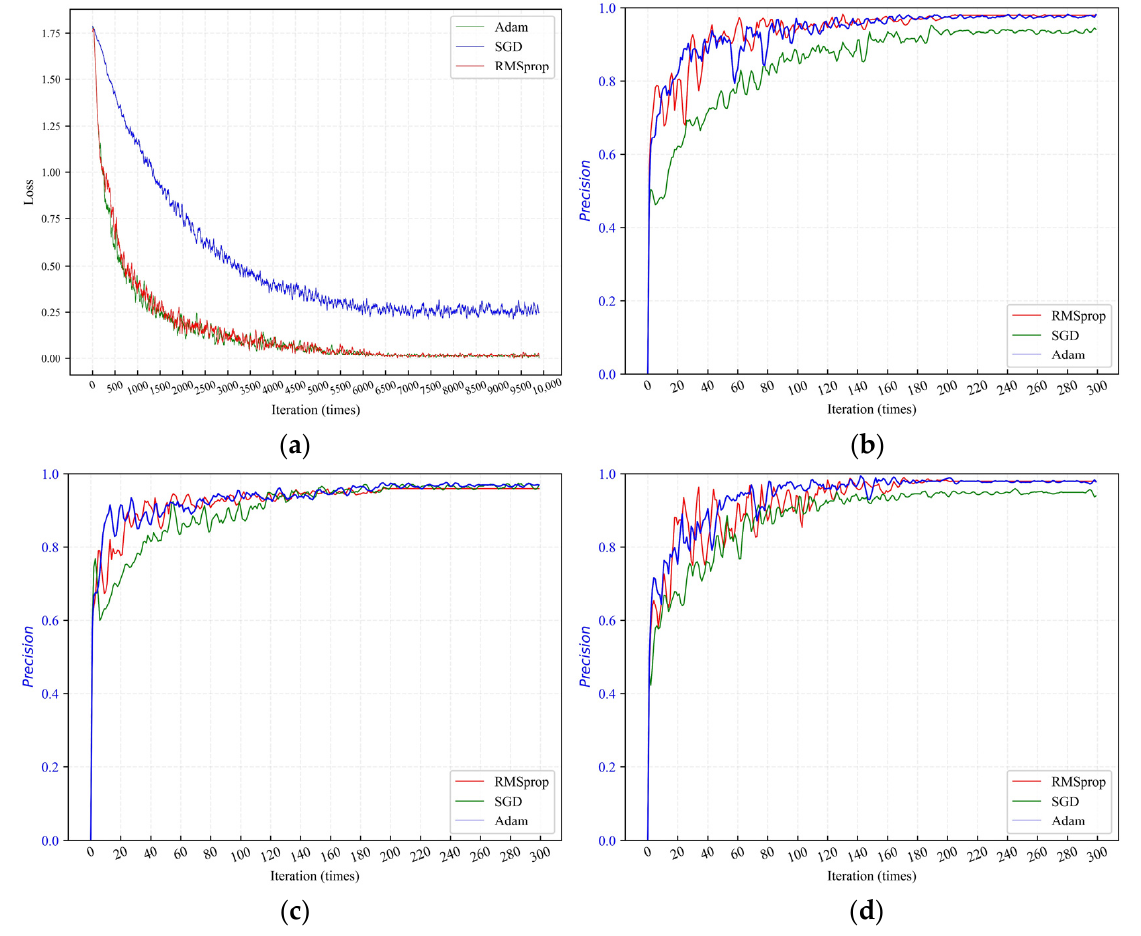
Figure 11. ( a ) Training loss of GoogLeNet under three optimizers; ( b ) classification precision of metamorphic rock under three optimizers; ( c ) classification precision of sedimentary rock; and ( d ) classification precision of volcanic rock.